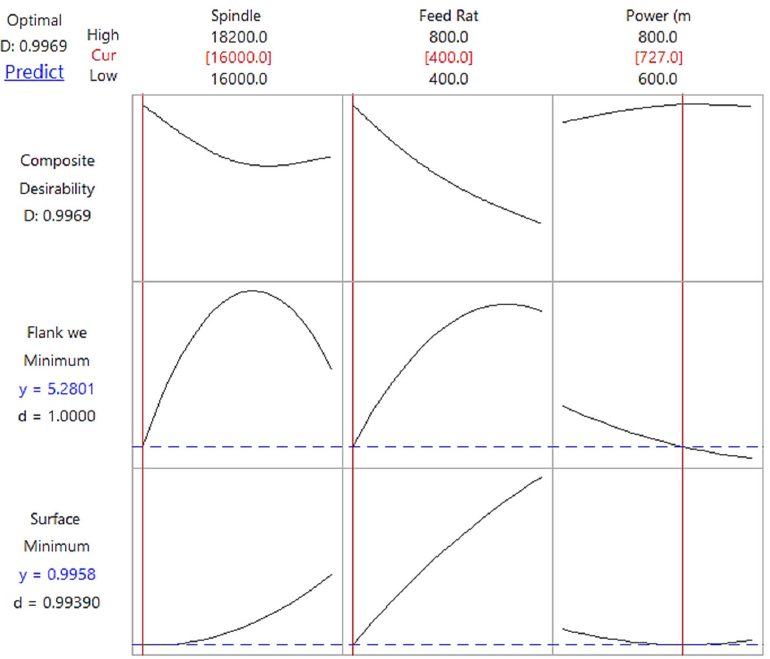
Figure 11. Response optimization plot of cutting parameters and the predicted results of flank wear and surface roughness with water-soluble sago starch cutting fluid.